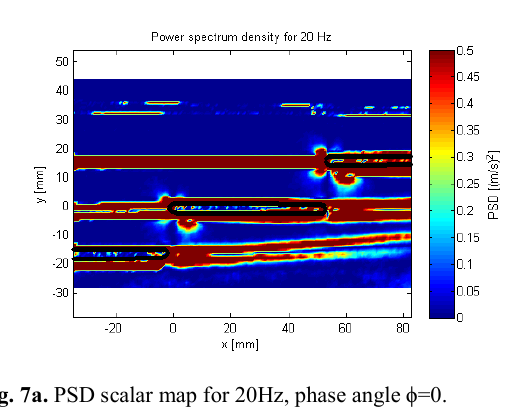
Fig. 6a. PSD scalar map for 20Hz, 20m/s for u-component.